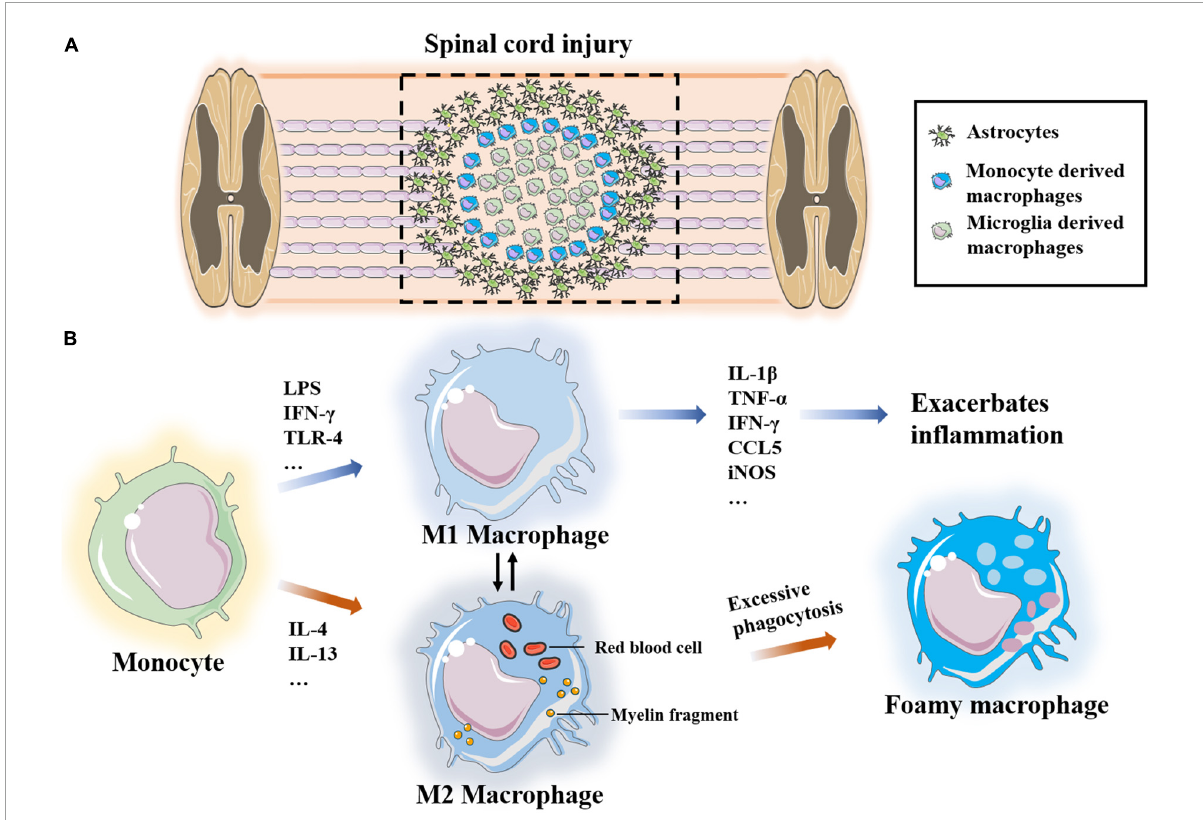
FIGURE6 (A) Microglia-derived macrophages form boundaries at the site of injury and monocyte-derived macrophages infiltrate into the site of injury. (B) Monocytes polarize into two different phenotypes M1 and M2 under the stimulation of different factors, which transform into each other. Excessive phagocytosis of myelin sheath fragments and apoptotic cells induce macrophages transform into foam